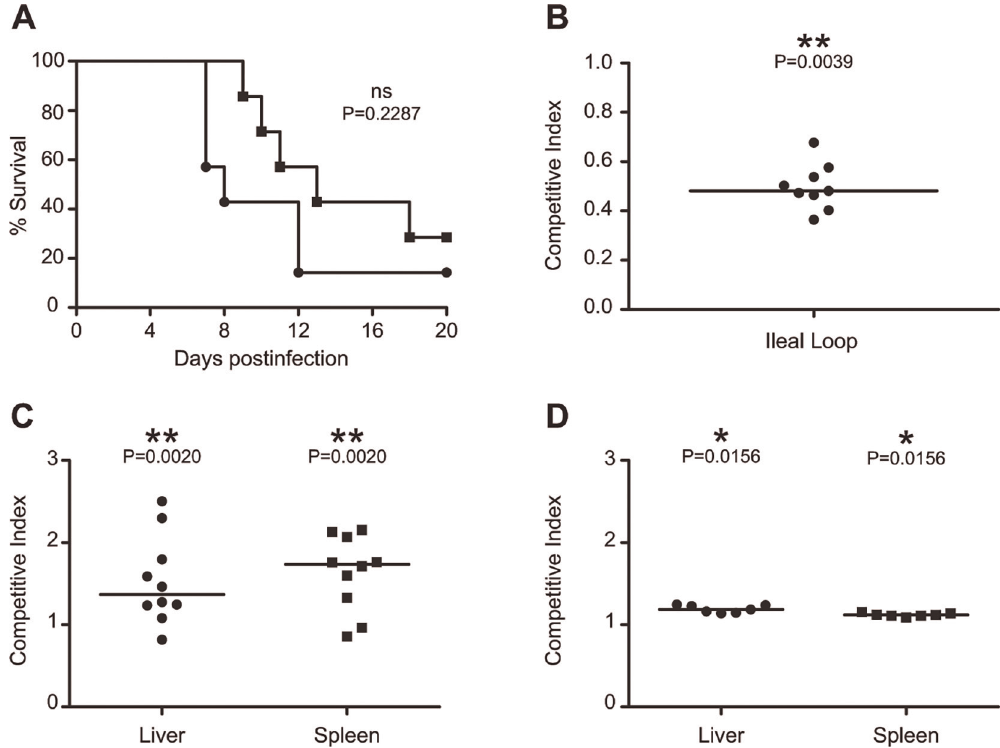
Fig 1. c-di-GMP signaling in Salmonella is required for intestinal epithelium and organ colonization of BALBc mice but its absence does not significantly affect BALBc mice survival. (A) Comparative lethality between wild-type (black circles) and Δ XII (black squares) strains in an oral infection mouse model. Inoculum administered was 10 7 cfu/mouse. P-value was determined by a Log-rank (Mantel-Cox) test. ns; no significant difference. (B) Competitive index (CI) analysis of wild type and Δ XII strains after performing an ileal loop coinfection experiment. Nine ileal loops were coinfected with 2x10 7 cfu containing equal numbers of the parental and Δ XII strains. (C) CI analysis following intragastric inoculation of ten BALBc mice with a 1:1 mixture of wild type and Δ XII strains (total inoculum administered was 2 x 10 8 cfu). Mice were sacrificed after five days and bacteria were enumerated from livers and spleens. (D) CI analysis following intraperitoneal inoculation of seven BALBc mice with a 1:1 mixture of wild type and Δ XII strains (total inoculum administered was 2 x 10 4 cfu). Mice were sacrificed three days postinoculation and bacteria were enumerated from livers and spleens. CI was defined as the log 10 of the ratio of wild type strain to Δ XII strain recovered (Output) divided by the ratio of wild type strain to Δ XII strain present in the inoculum (Input). A CI > 0 indicates wild type with a colonization advantage compared to Δ XII and a CI < 0 indicates wild type with a colonization disadvantage over Δ XII. The plots display values obtained from individual samples and the median CI is represented by horizontal bars. P-values were determined by a Wilcoxon signed- rank test. * P < 0.05; ** P < 0.01; *** P <